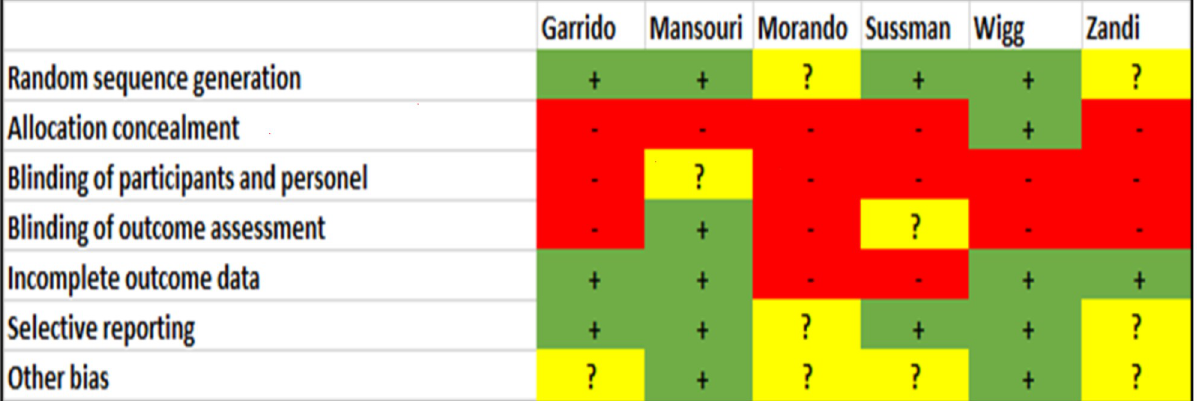
Fig 2. Bias assessment of the randomized controlled trials. Guided by the Cochrane Handbook for Systematic Reviews of Interventions.